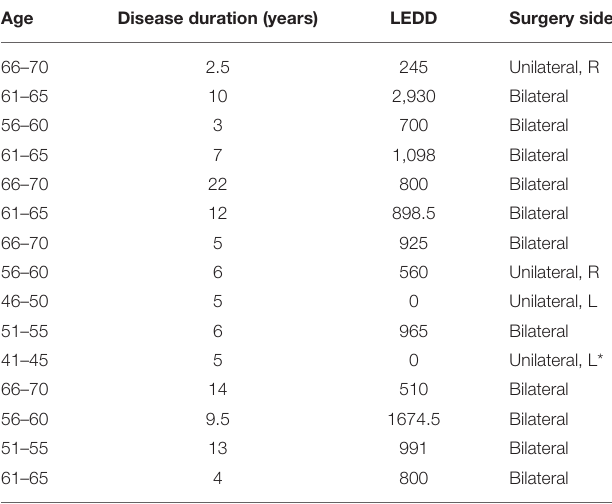
TABLE 1 | Patient